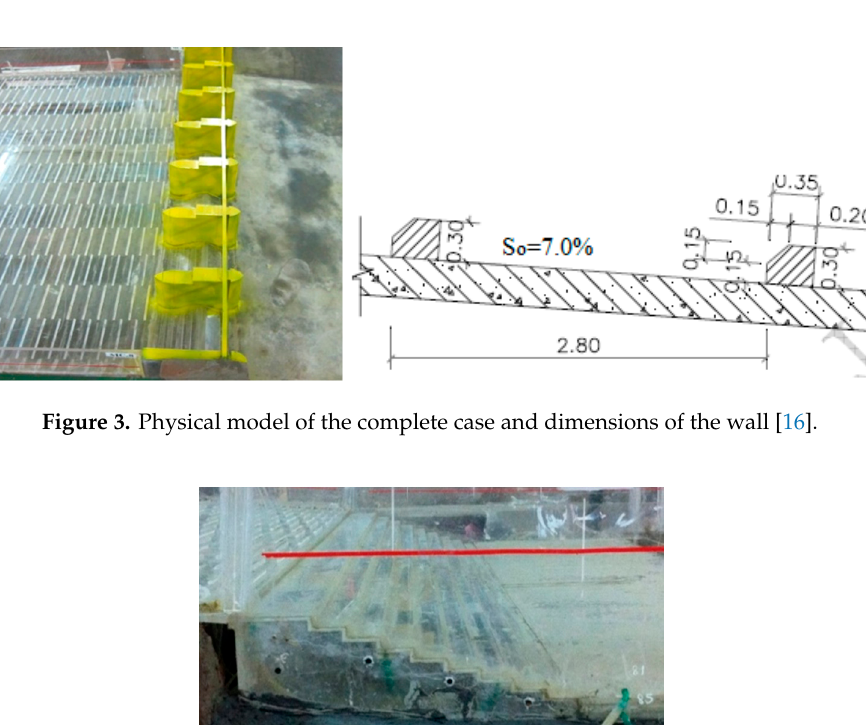
Figure 2. Physical model of the design case and dimensions of the step [16].